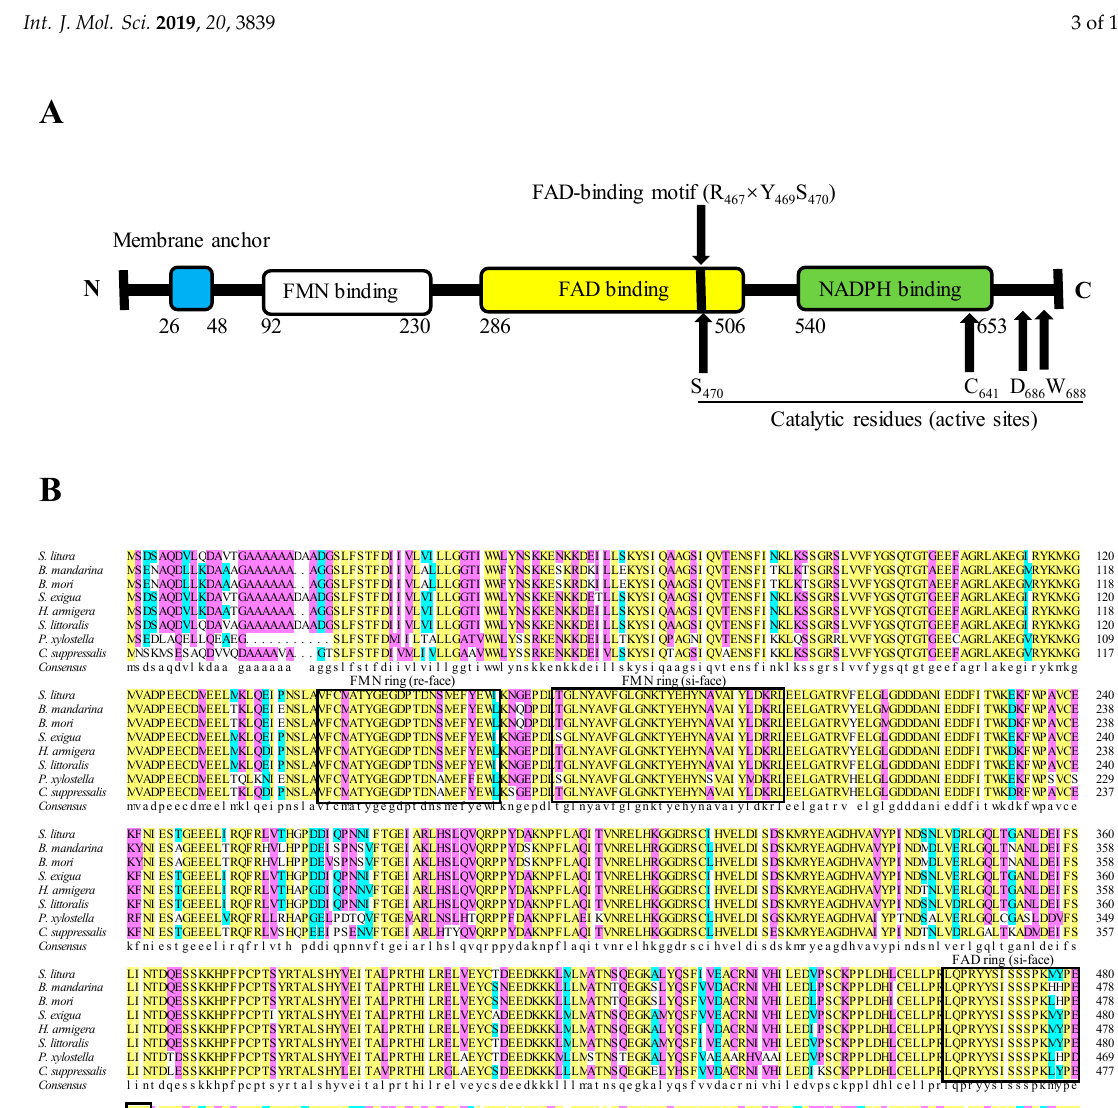
S. litura B. mandarina B. mori S. exigua H. armigera S. littoralis P. xylostella C. suppressalis Consensus NADPH Adenine Figure 1. Sequence analysis of the SlCPR protein ( A ). The protein contains predicted flavin mononucleotide (FMN)-, flavin adenine dinucleotide (FAD)-, and NADP-binding domains. The proteins also conserved residues such as the FAD-binding motif (R467, Y469, and S470) and the predicted catalytic residues (S470, C641, D686, and W688). ( B ) Comparison of the deduced amino acid sequence of SlCPR with other NADPH-cytochrome P450 reductases (CPRs). Accession numbers of indicated CPR amino acid sequences are shown in Table 1.